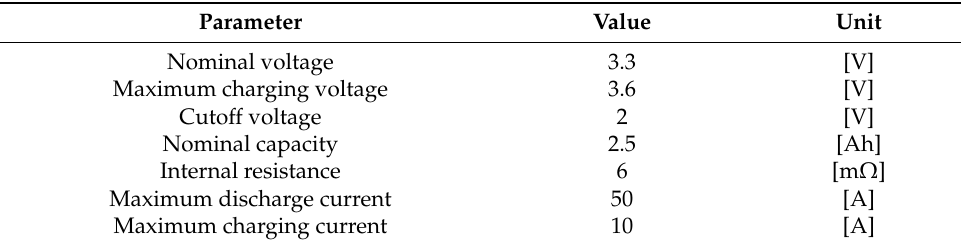
Table 1. The ANR26650M1-B of A123 cell parameters.